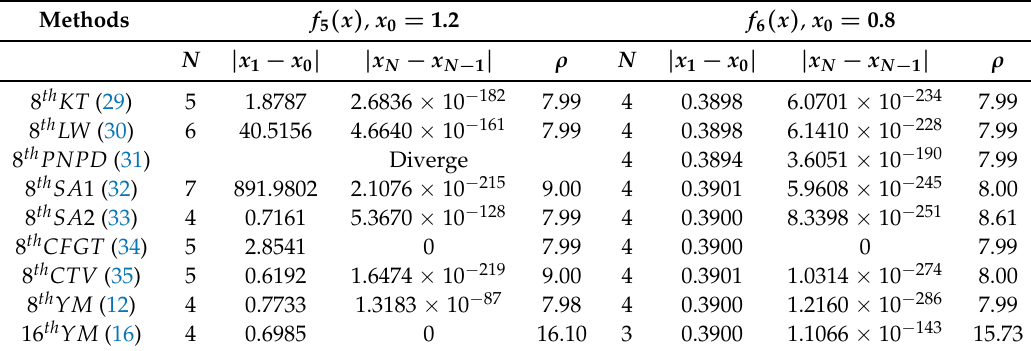
Table 5. Numerical results for nonlinear